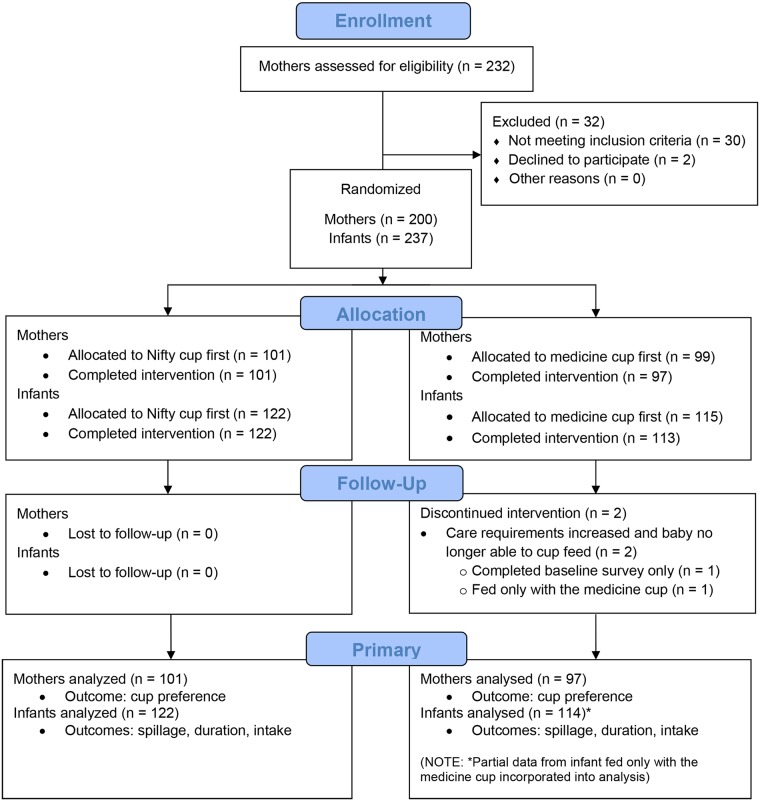
CONSORT flow diagram.